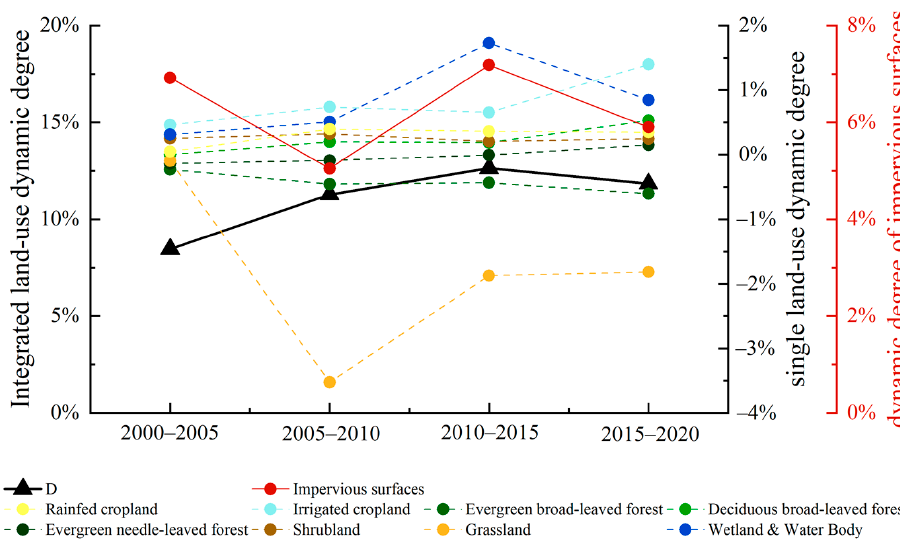
Figure 3. dynamic degree of LUCC in Laos from 2000 to 2020. Figure 3. Dynamic degree of LUCC in Laos from 2000 to 2020. From a spatial perspective (Figure 4), the land change dynamics in the northern and southern ends of Laos were high, while the land change dynamic in the central region was relatively low. From 2000 to 2005, the integrated land-use dynamic degrees in most provinces were below 15%, the lowest was 6.3% (Borikhamxay), and the highest was 20.7% (Oudomxay). The high-intensity LUCC in Oudomxay in the north was mainly due to the extensive expansion of the impervious surface (+80.4%) in Muang Xay, the capital of the province. From 2005 to 2010, the activity of LUCC in northern and southern Laos decreased, and the integrated land-use dynamic degrees in most provinces were below 10%. Compared with the previous period, the lowest (6.9%, Savannakhet) and highest (35.1%, Xaysomboon) integrated land use dynamic degrees have increased. Data showed that the changing intensity of impervious surface was the main factor affecting the land use dynamics. From 2010 to 2015, the intensity of LUCC in all provinces showed an upward trend. During this period, the integrated land-use dynamic degrees in most provinces exceed 10%, the lowest was 7.2% (Champasack), and the highest was 249.9% (Xaysomboon). The main reason for the drastic LUCC in Xaysomboon was the large expansion of grassland (+1054.4%). In addition, there were also large-scale increases in impervious surface (+124.8%), wetland and water body (+51.5%) in the province. From 2015 to 2020, the intensity of LUCC in the northern and southern regions increased, and the land use activity in the central region decreased. Most provinces’ integrated land-use dynamic degree exceeded 15%, with the lowest being 7.9% (Vientiane Capital) and the highest being 50.2% (Attapeu). The increased LUCC in the south of Attapeu was mainly due to the rapid growth of wetland & water body